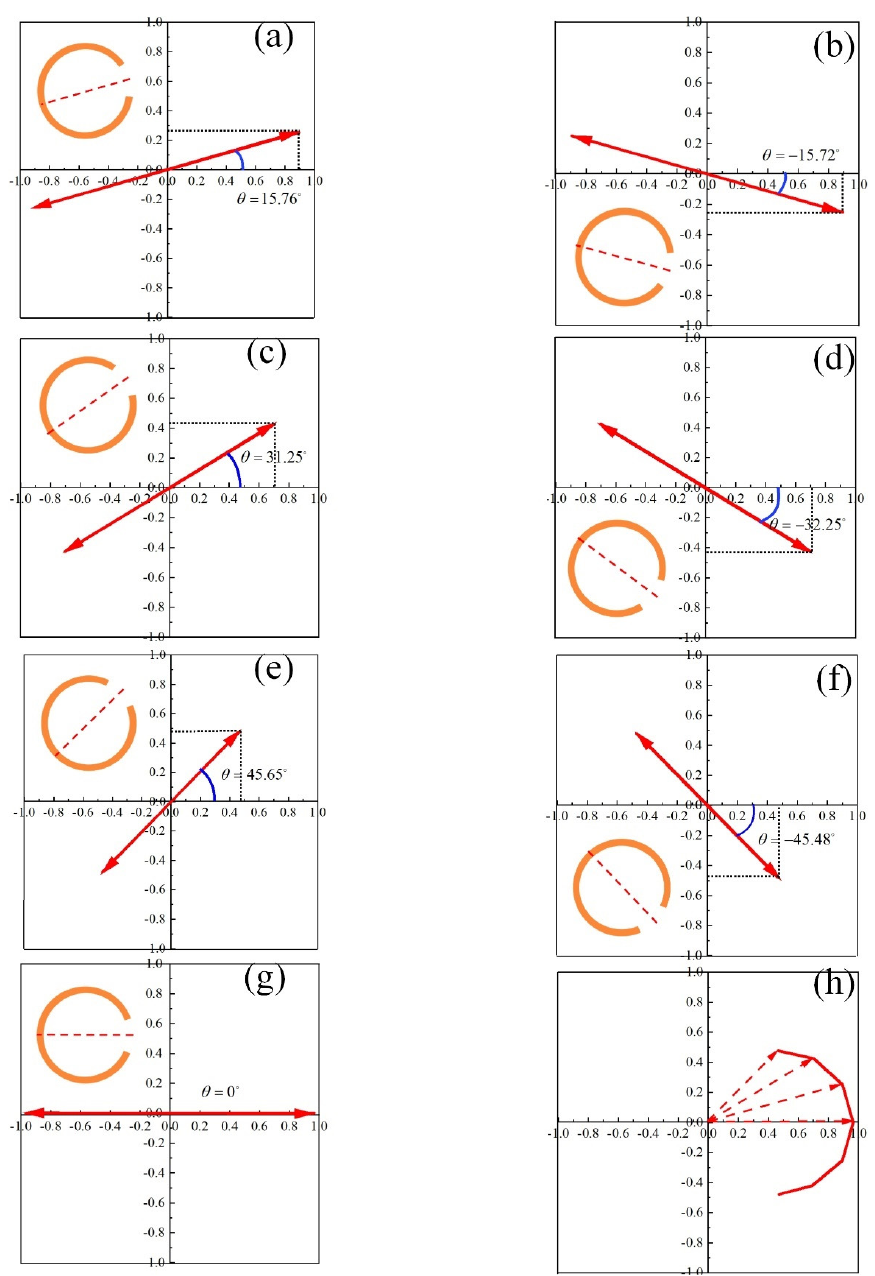
Figure 2. Variation of electric field of scattered light in time domain at z = − 10 µ m for ( a ) γ = + 15 ◦ and ( b ) γ = − 15 ◦ , ( c ) γ = + 30 ◦ and ( d ) γ = − 30 ◦ , ( e ) γ = + 45 ◦ and ( f ) γ = − 45 ◦ , ( g ) γ = 0 ◦ . ( h ) Electric field vector of the scattered light with γ varying from − 45 ◦ to +45 ◦ at 0.84 THz.